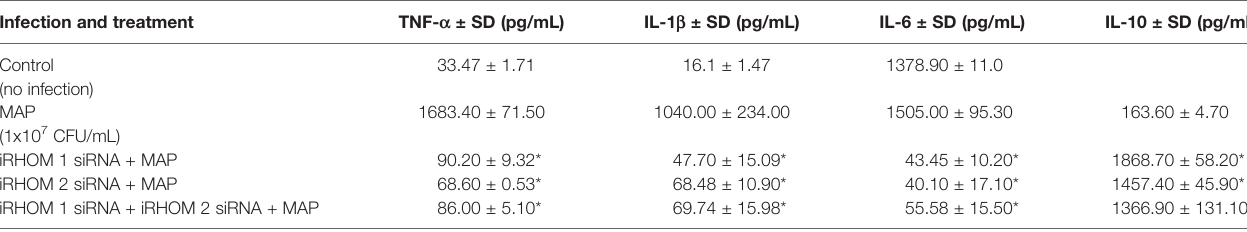
*Indicates P-value of less than